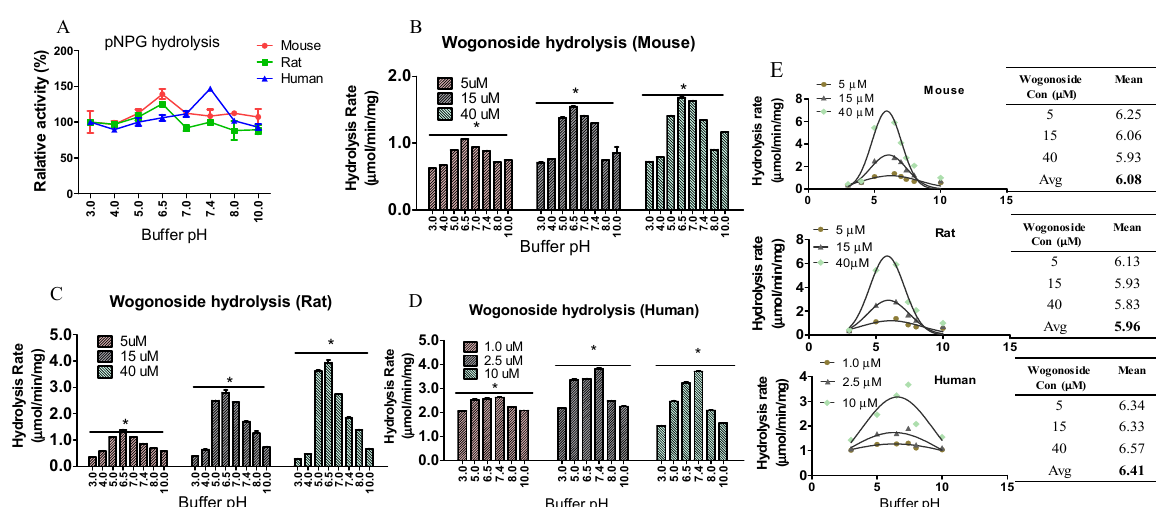
Figure 6. Impact of buffer pH on pNPG ( A ) and wogonoside ( B , mouse, C , Rat, D , Human) hydrolysis. The pNPG (final concentration, 1 mM) or wogonoside was incubated with the enzymes in buffers at different pH for 30 min at 37 °C (n = 3, * p < 0.05, One-Way ANOVA). The results showed that pH 7.4 and 6.5 are the favorite pH for human and rodent fecal S9, respectively. The favorite pH for these fecal enzymes was calculated using functional dependency calculation; ( E ) Avg, average, Gaussian distribution.